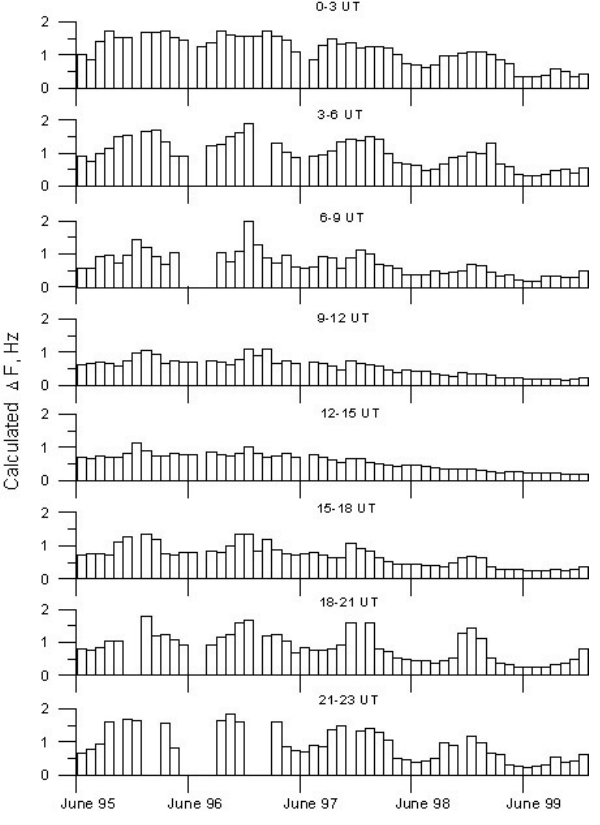
Fig. 7. The long-term variations of the parameter L , characterising the upper ionosphere electron density decay, inferred from the SRS frequency scale and ionosonde fo F2 measurements made in